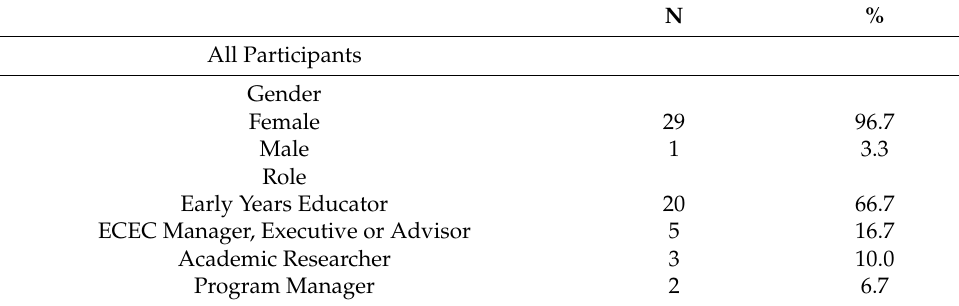
Table 1. Demographic characteristics of the